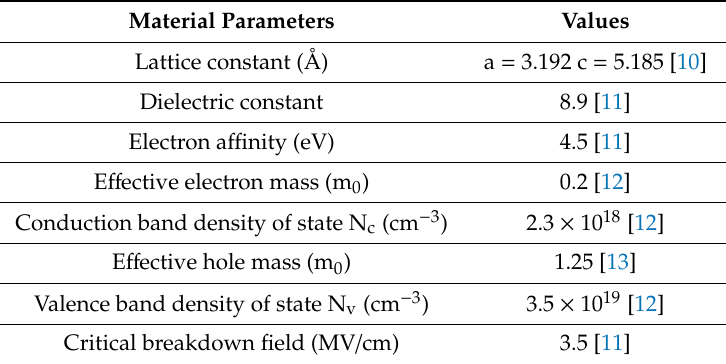
Table 1. Material parameters of Wurtzite GaN.